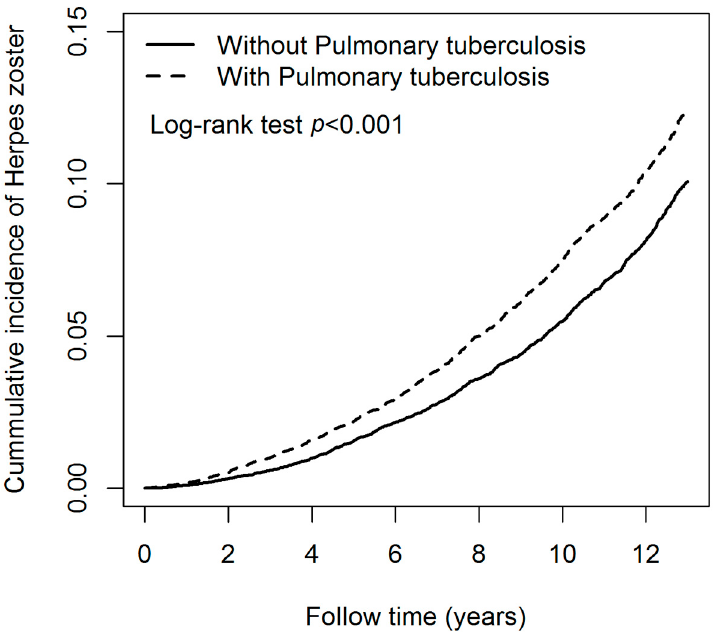
Figure 2. Kaplan-Meier curves of the cumulative incidence rate of herpes zoster during the follow-up period among patients with and without pulmonary tuberculosis. Table 2. Incidences and hazard ratios of herpes zoster for individuals with and without pulmonary tuberculosis by gender, age, and comorbidities.